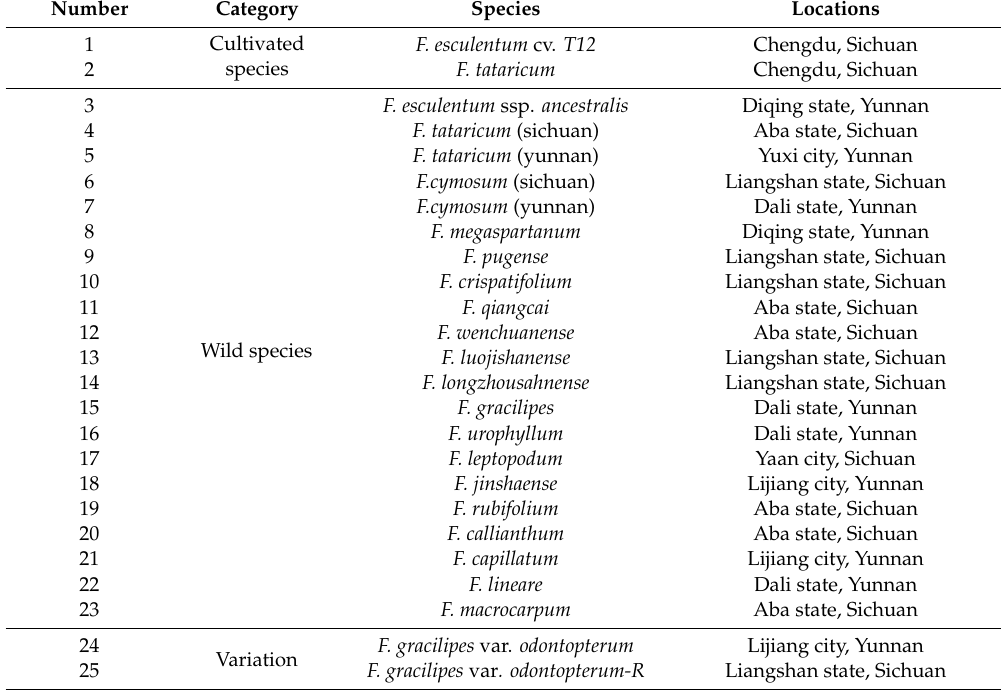
Table 1. Materials and collecting places of Fagopyrum species used in this